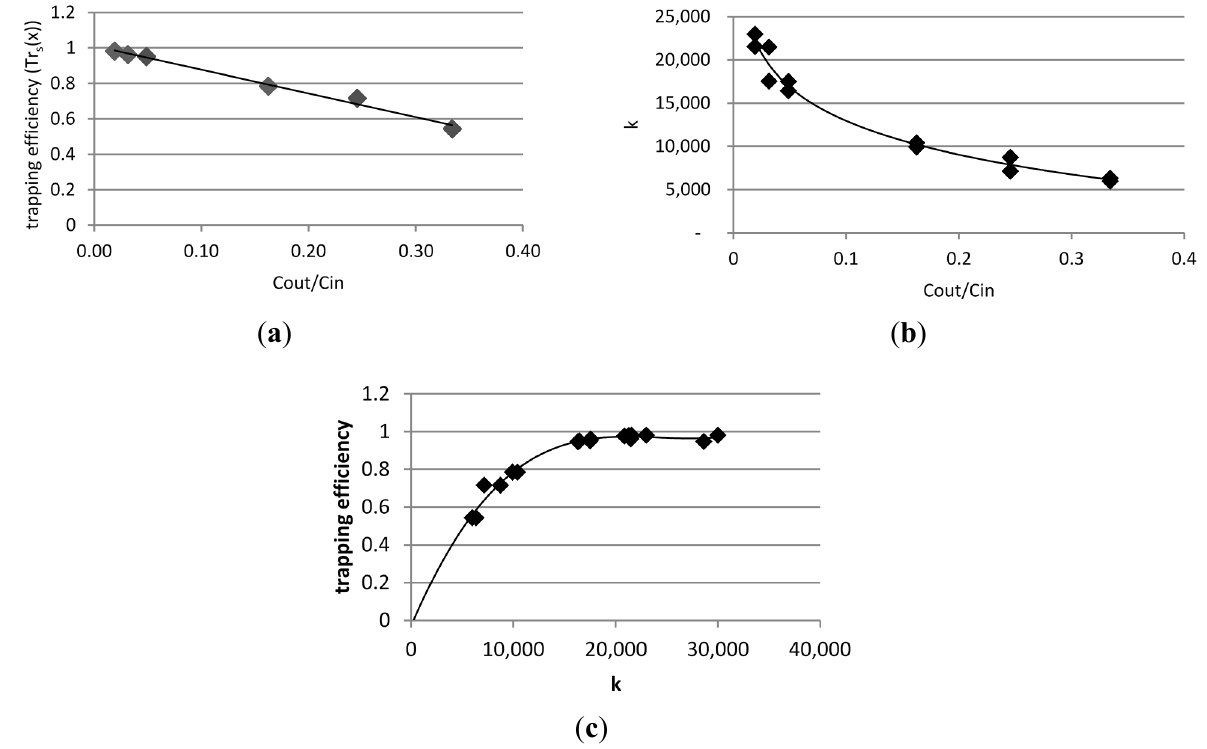
Figure 7. Correlation between sediment detention rate and ( a ) trapping efficiency; ( b ) first order decay rate constant k; and a comparison of ( c ) trapping efficiency and first order decay rate constant